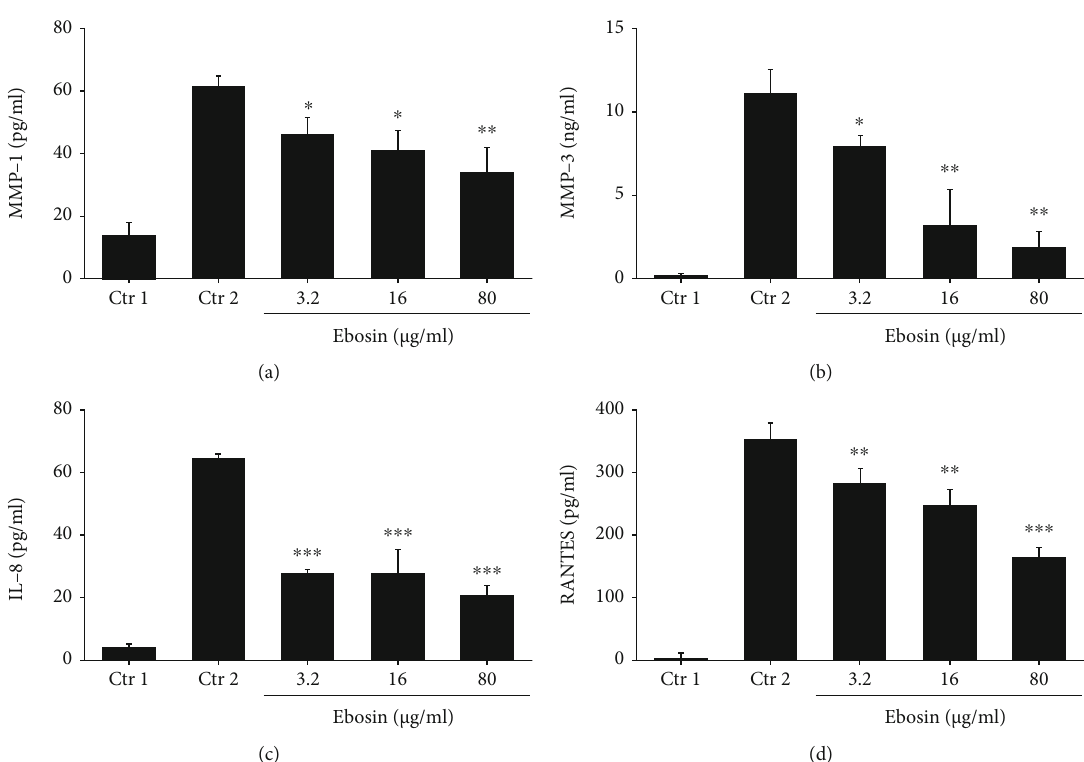
Figure 5: Ebosin suppresses production of MMPs and chemokines mediated by TNF- α in FLS. (a, b) Inhibition of ebosin on production of MMP1 and MMP3. FLS cells ( 1 × 10 6 /ml ) were incubated in the presence or absence of ebosin for 12 h then with TNF- α (10 ng/ml) for 24 h. The expression levels of MMP1 and MMP3 were analyzed by ELISA kits individually. (c, d) In fl uences of ebosin on production of chemokines including RANTES and IL-8. The levels of RANTES and IL-8 were determined also by ELISA kits separately. P < 0 : 001 , P < 0 : 01 , and P < 0 : 05 compared to the control 2 (FLS incubated with TNF- α